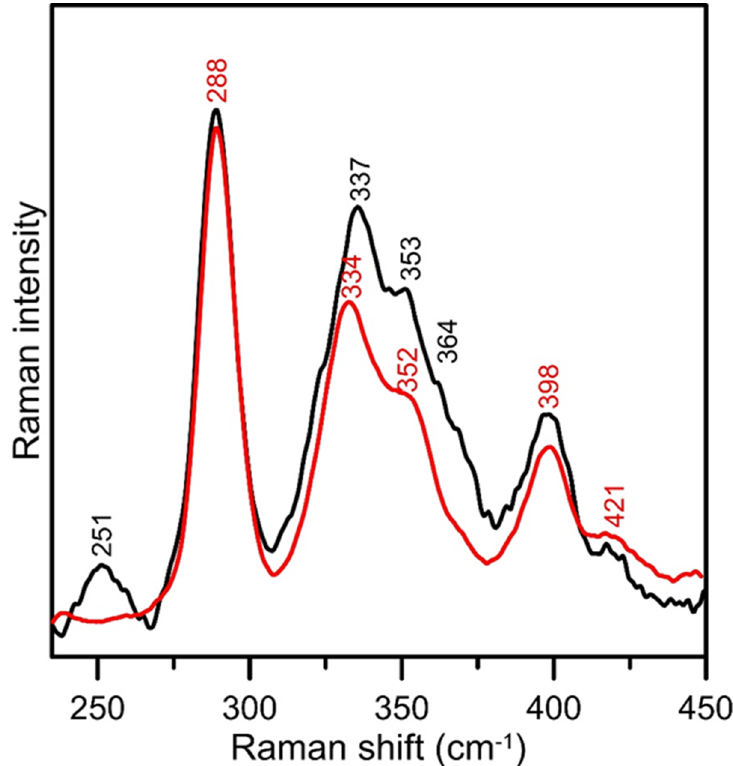
Figure 8. Comparison of the resonance Raman spectra of [2Fe-2S] 2+ cluster-bound as-isolated At ISCA1a/2 (red line) and [4Fe-4S] 2+ cluster-bound reconstituted At ISCA1a/2 (black line) using 458-nm laser excitation . The samples (~2 mM [2Fe-2S] 2+ or [4Fe-4S] 2+ clusters) in 100 mM Tris-HCl buffer at pH 7.8 were in the form of frozen droplets at 17 K. The spectra are the sum of 100 individual scans with each scan involving photon counting for 1 s at 0.5 cm − 1 increments with 7 cm − 1 spectral resolution. Bands due to lattice modes of the frozen buffer solution have been subtracted from both spectra.